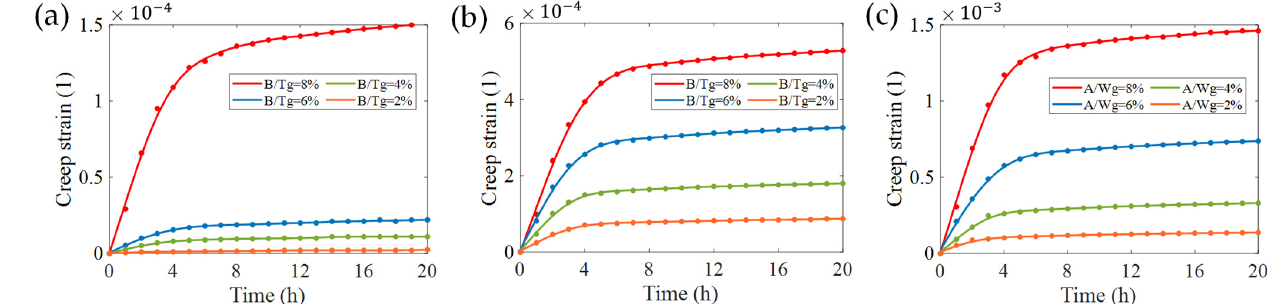
6 of 10 Table 3. Creep constants of constantan alloy Creep Rate Coefficient 𝑪 (1/h) Stress Exponent 𝒏 (MPa) Time Hardening Exponent 𝒎 3.125 × 10 –14 1 0.5 Figure 7. ( a ) Step load applied for the creep simulation; ( b ) S–N curve of alloy steel used. The fatigue curve (also called S–N curve) describes correlations between the value of stress 𝜎 (cid:3028) and the number of cycles 𝑁 (cid:3033) when fatigue damages occur in metal structures [18,19]. During fatigue simulation, the S–N curve of alloy steel shown in Figure 7b was selected as the reference criteria. For the fatigue life of strain gauges, which is commonly measured under uniaxial cyclic stress, we set the cyclic stress ratio to 0 in order to fit the reality. In this case, the fatigue life obtained is the maximum one. Under different loads, by calculating the maximum stress value in the stress distribution of the models, we can obtain the fatigue life for corresponding load through S–N curve. Moreover, for creep and fatigue are both dynamic processes, transient was set as the research object in all simulations. Please see supplementary material for the detailed the- oretical description of creep and fatigue life [11,15,16,18,20–24]. 3. Results and Discussion